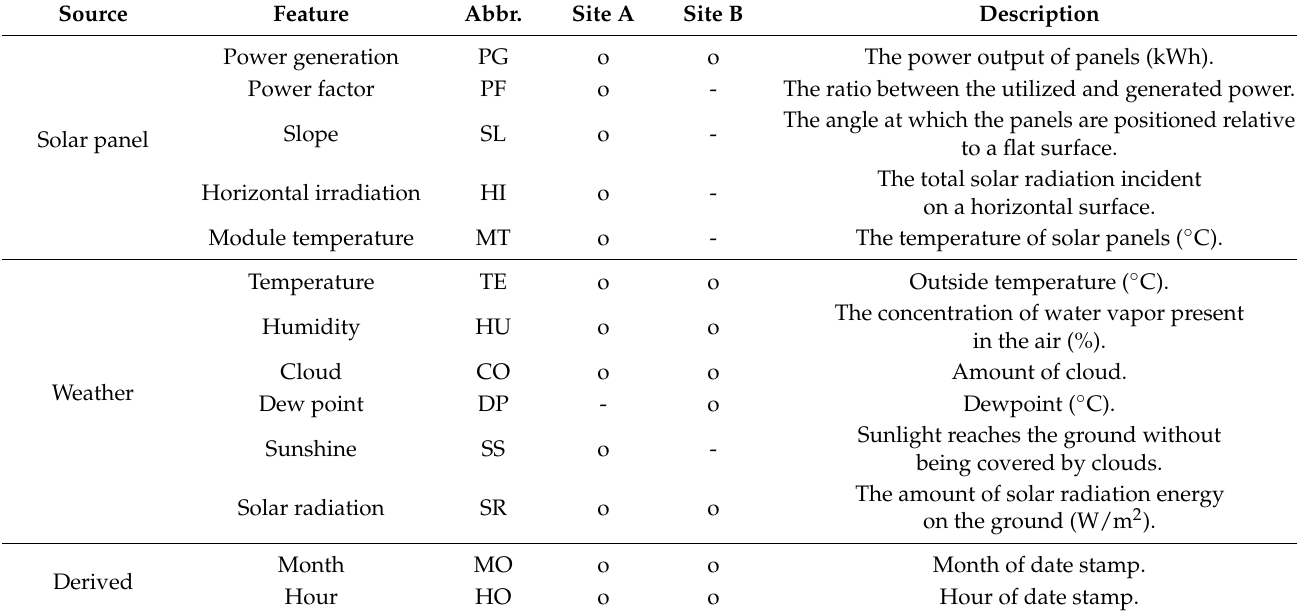
Table 2. Feature description of